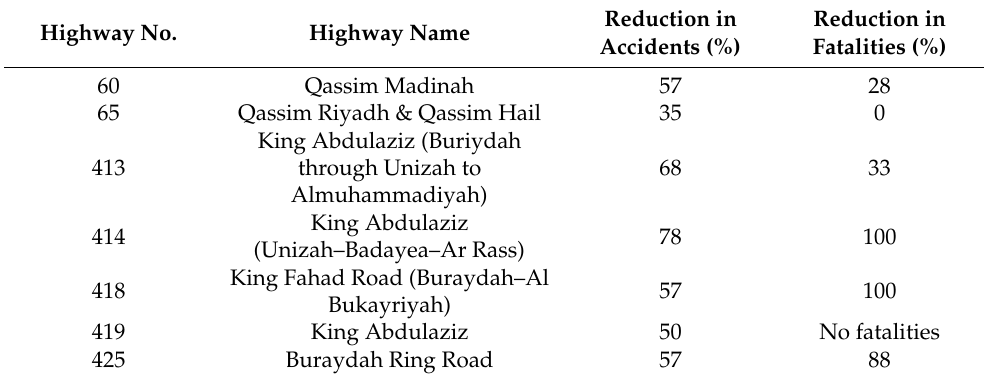
Table 5. Summary of accident data on main roads in Qassim Region before and after installation of speed